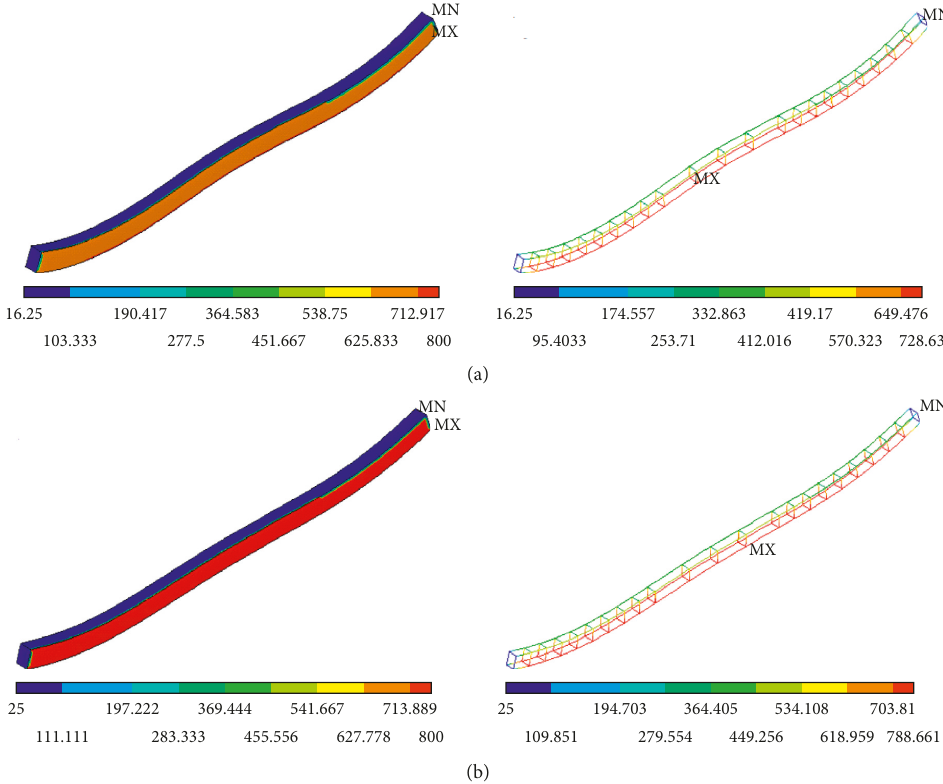
Figure 10: Thermal stress contour at different time (150mm